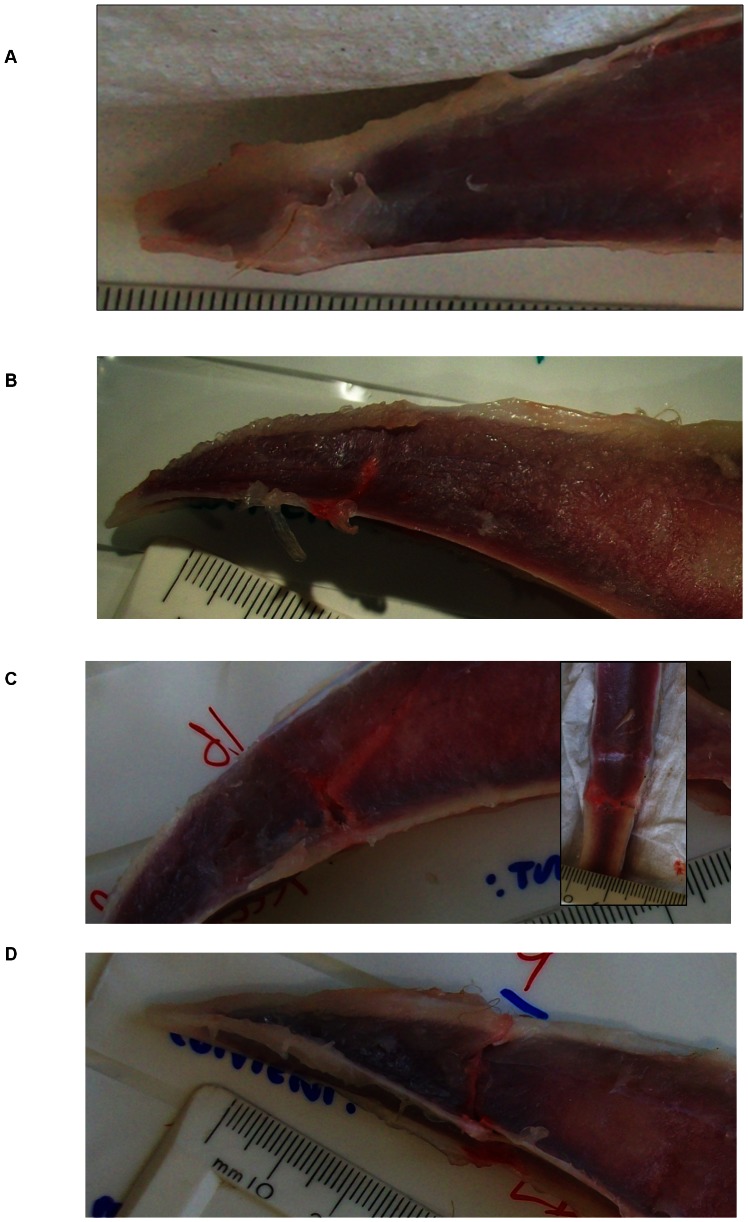
Severity score assessing the extent of damage.Hash marks indicate 1 mm.Panel A: Severity score = 0: No fracture. Panel B: Severity Score = 1: Small transverse fracture on the ventrolateral or dorsolateral aspect of the keel plate without extending to the ventral borders. Panel C: Severity Score = 2: Large transverse fracture extending from the ventral to the dorsal borders. The impact fracture can also be seen on the dorsoventral aspect of the base of the keel (inset). Panel D: Large transverse impact fracture extending from the ventral to the dorsal borders of the keel bone resulting in displacement of the tip of the keel bone.